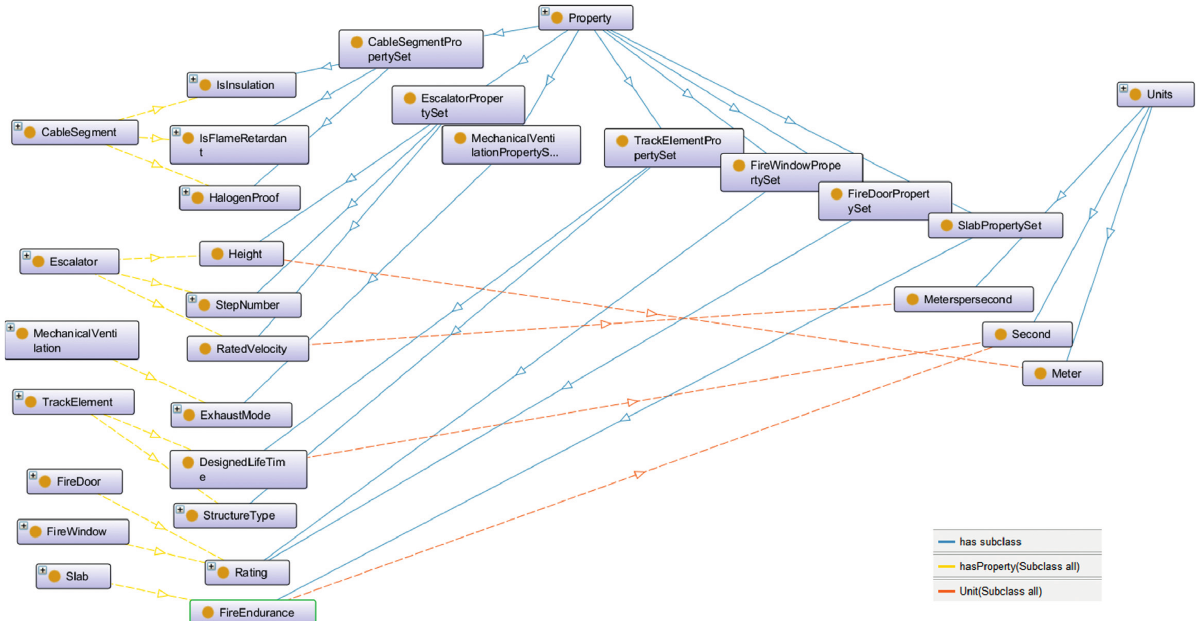
Figure 15: The property extension in code